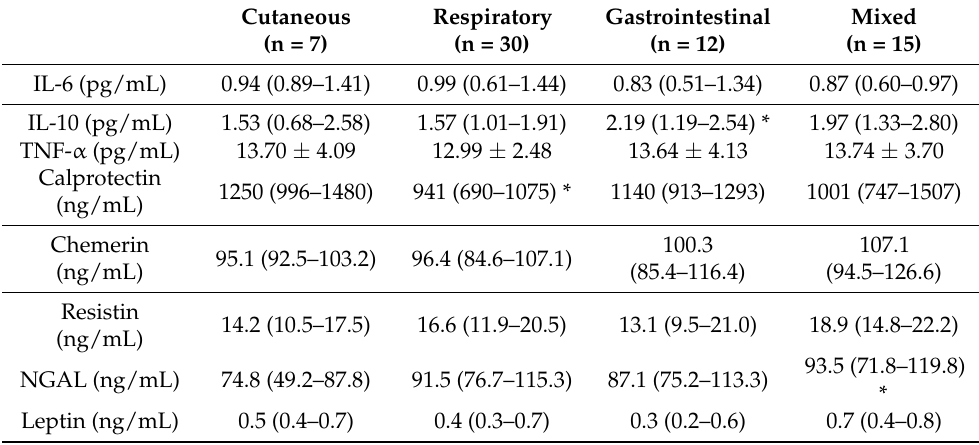
Table 4. Serum cytokine, calprotectin and adipokine concentrations in the subgroups of CMA patients with different clinical symptoms.